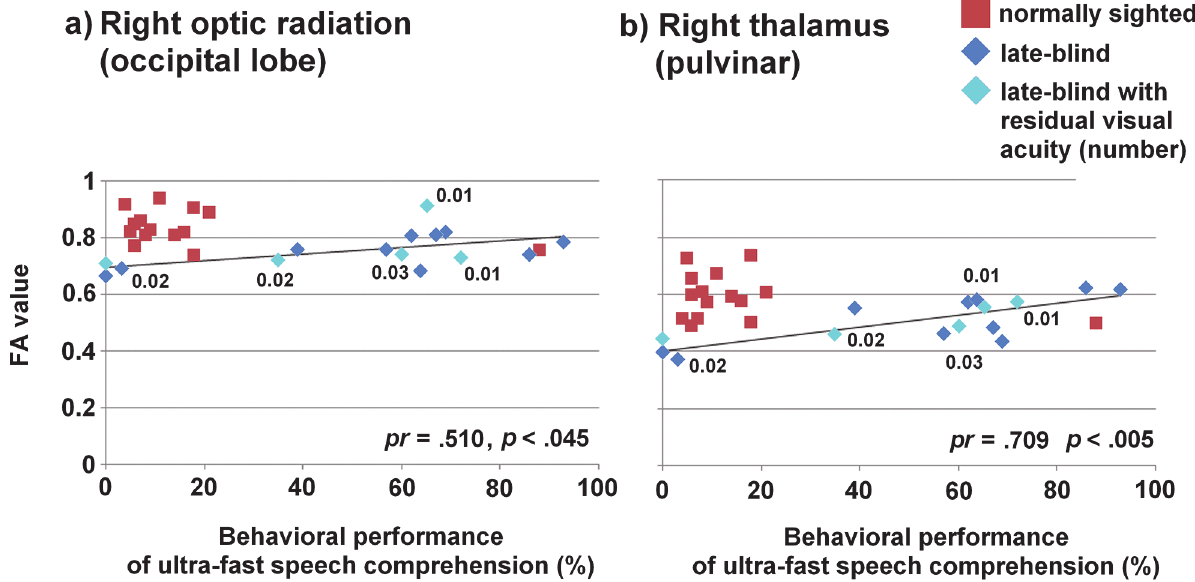
Fig 4. Scatter plots of FA values against the individual behavioral performance of understanding ultra-fast speech. Regression lines, partial correlation coefficients, and significance levels refer to the late-blind group (blue diamonds) only, sighted controls (red squares) are only plotted for descriptive comparison. Values of visual acuity referred to late-blind individuals with residual visual perception (aqua